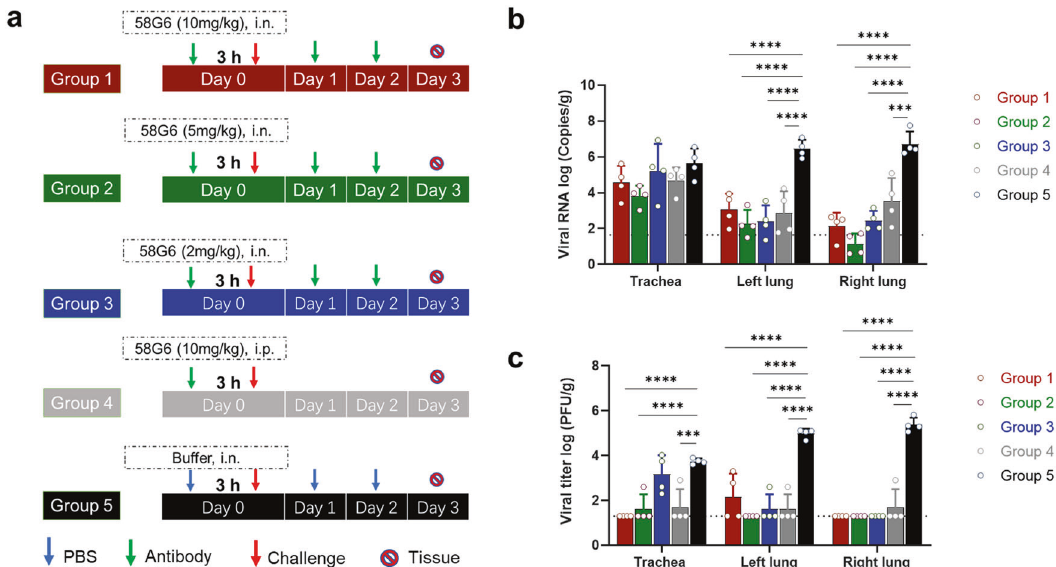
Fig. 5 Determination of the prophylactic dose of 58G6 against Omicron in the hamster model. a Animal experimental scheme. Group 1, 10 mg/kg 58G6 (3-dose for i.n.); Group 2, 5 mg/kg 58G6 (3-dose for i.n.); Group 3, 2mg/kg 58G6 (3-dose for i.n.); Group 4, 10 mg/kg 58G6 (1-dose for i.p.); Group 5, control group without 58G6. b Viral RNA copies in respiratory tracts of hamsters challenged with the Omicron variant at 3dpi. c The number of infectious viruses (PFUs) was measured in the respiratory tract at 3dpi by the viral plaque assay in Vero E6 cells. Bars indicate the mean